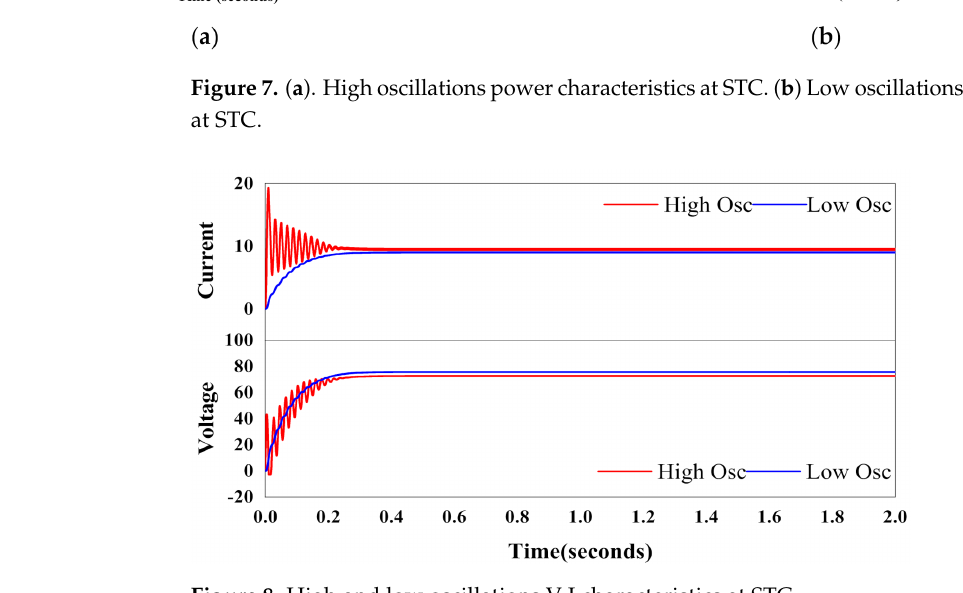
Figure 8. High and low oscillations V-I characteristics at